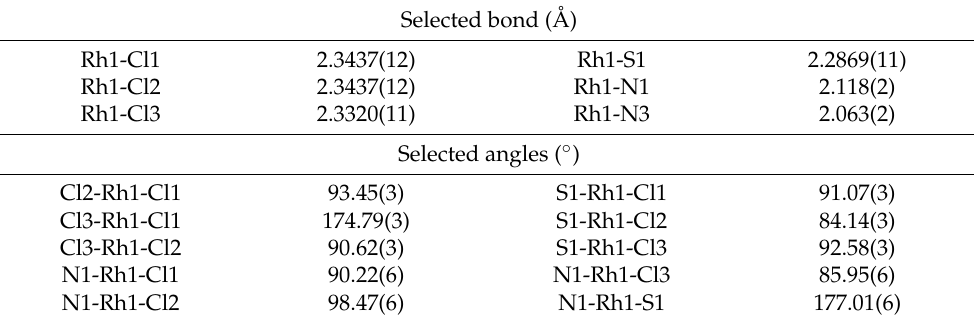
Table 2. Selected bond lengths and angles for 9-PMAH-Rh.